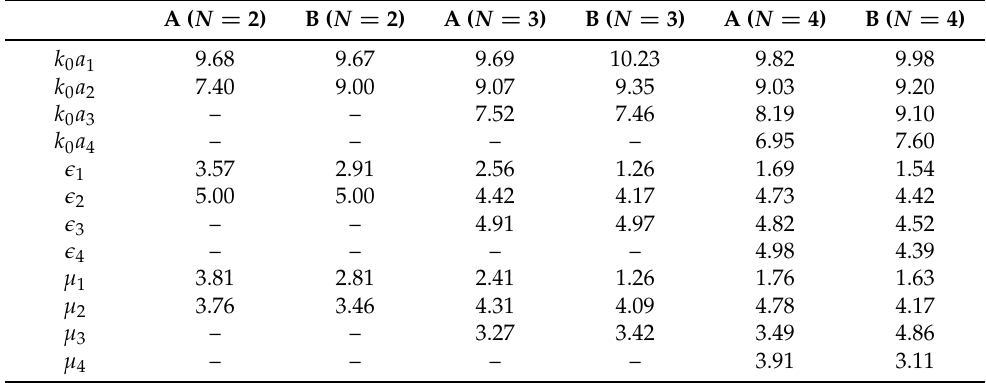
Table A5. Values of the optimization variables for optimized designs A and B of Figure 7.